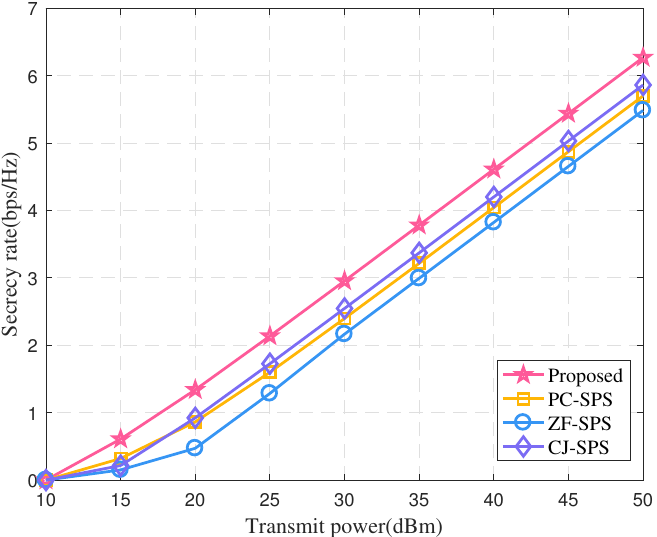
Figure 5. The secrecy rate vs. P s ( N = 20, K = 8).